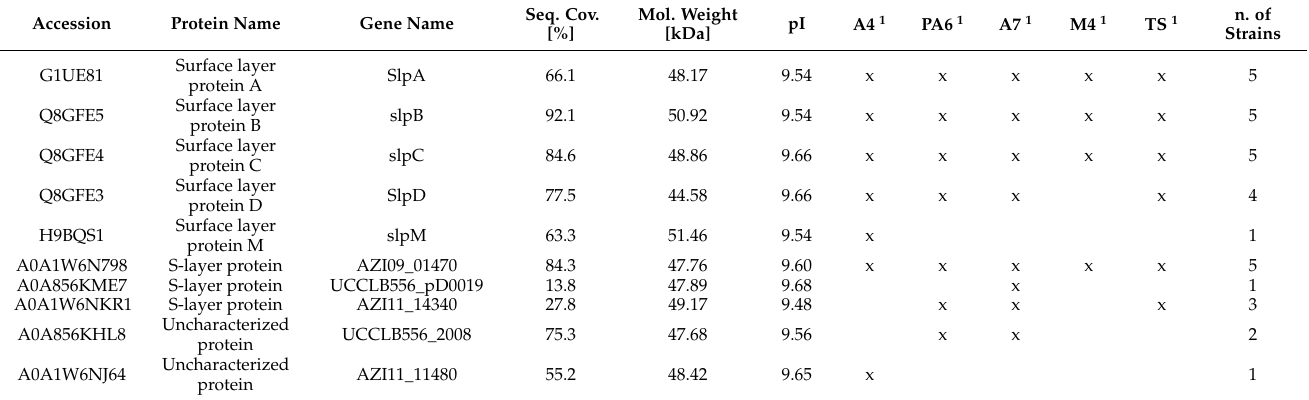
Table 1. Proteomic analysis of the surface layer protein (Slps) pattern in the five L. brevis strains.